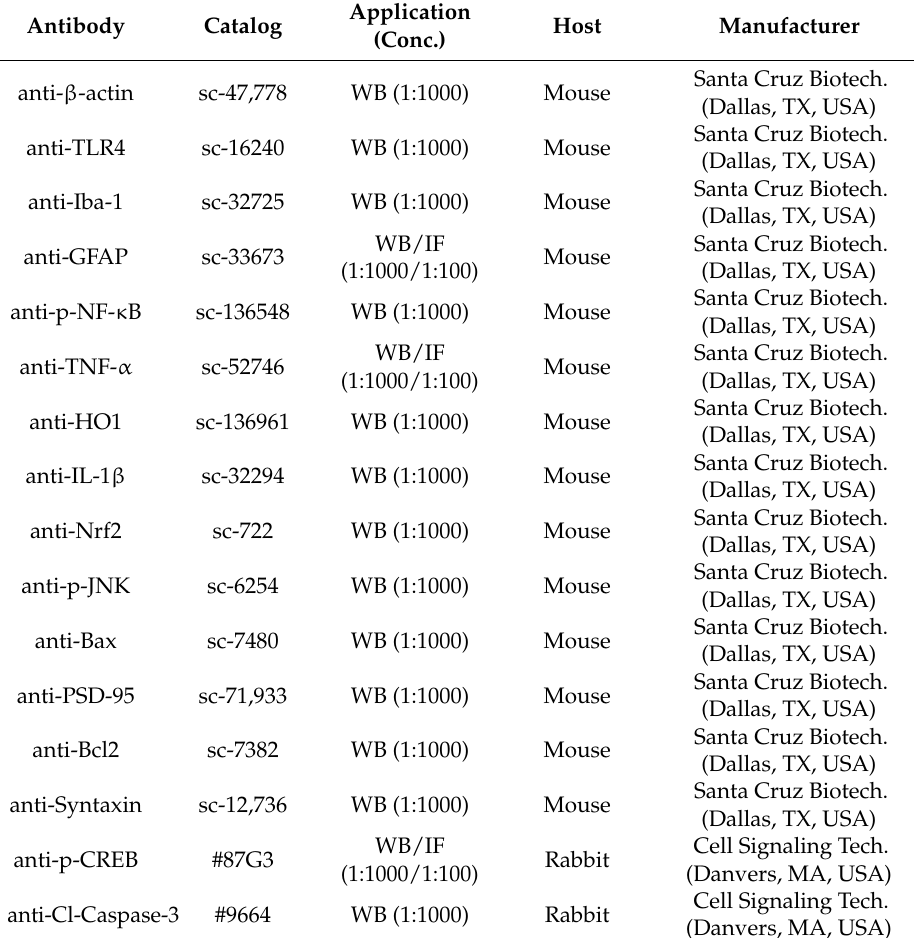
Table 1. List of primary antibodies and their information used in this